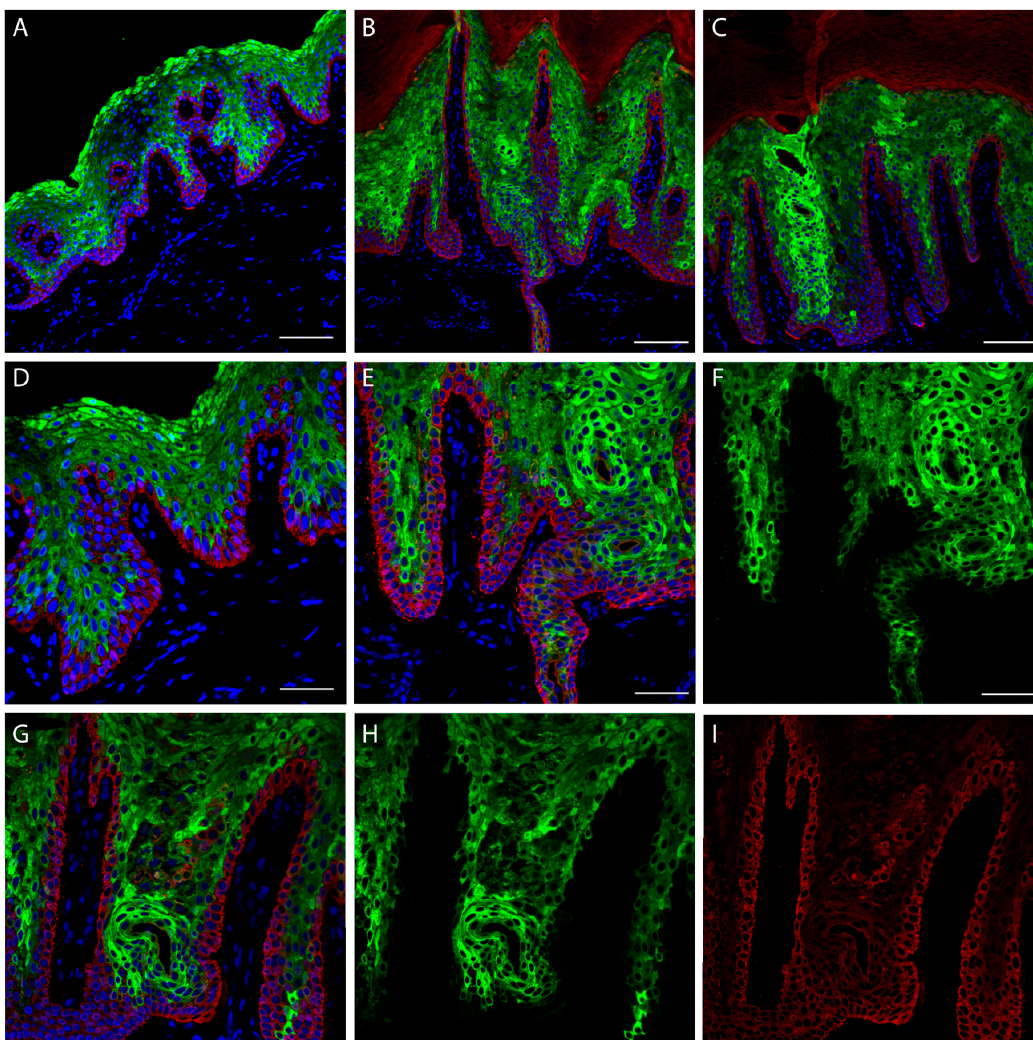
Figure 3. Skin confocal immunofluorescence analysis. Staining was performed using antibodies against K14 (red) and K1 (green). ( A ) Control palmar skin. ( B , C ) Patient palmar skin (20× objective). ( D ) Normal palmar skin (40× objective). ( E ), Patient palmar skin with K1 and K14 staining merged with DAPI (40× objective, also for ( F – I) . ( F ) Capture only showing K1 distribution. ( G ) Patient skin with merged channels showing K14, K1 and DAPI. ( H ) Patient skin showing only K1 staining. ( I ) Patient skin showing only K14 staining. ( A – F ) Scale bar = 100 μ m. ( G – I) Scale bar = 50 μ m.